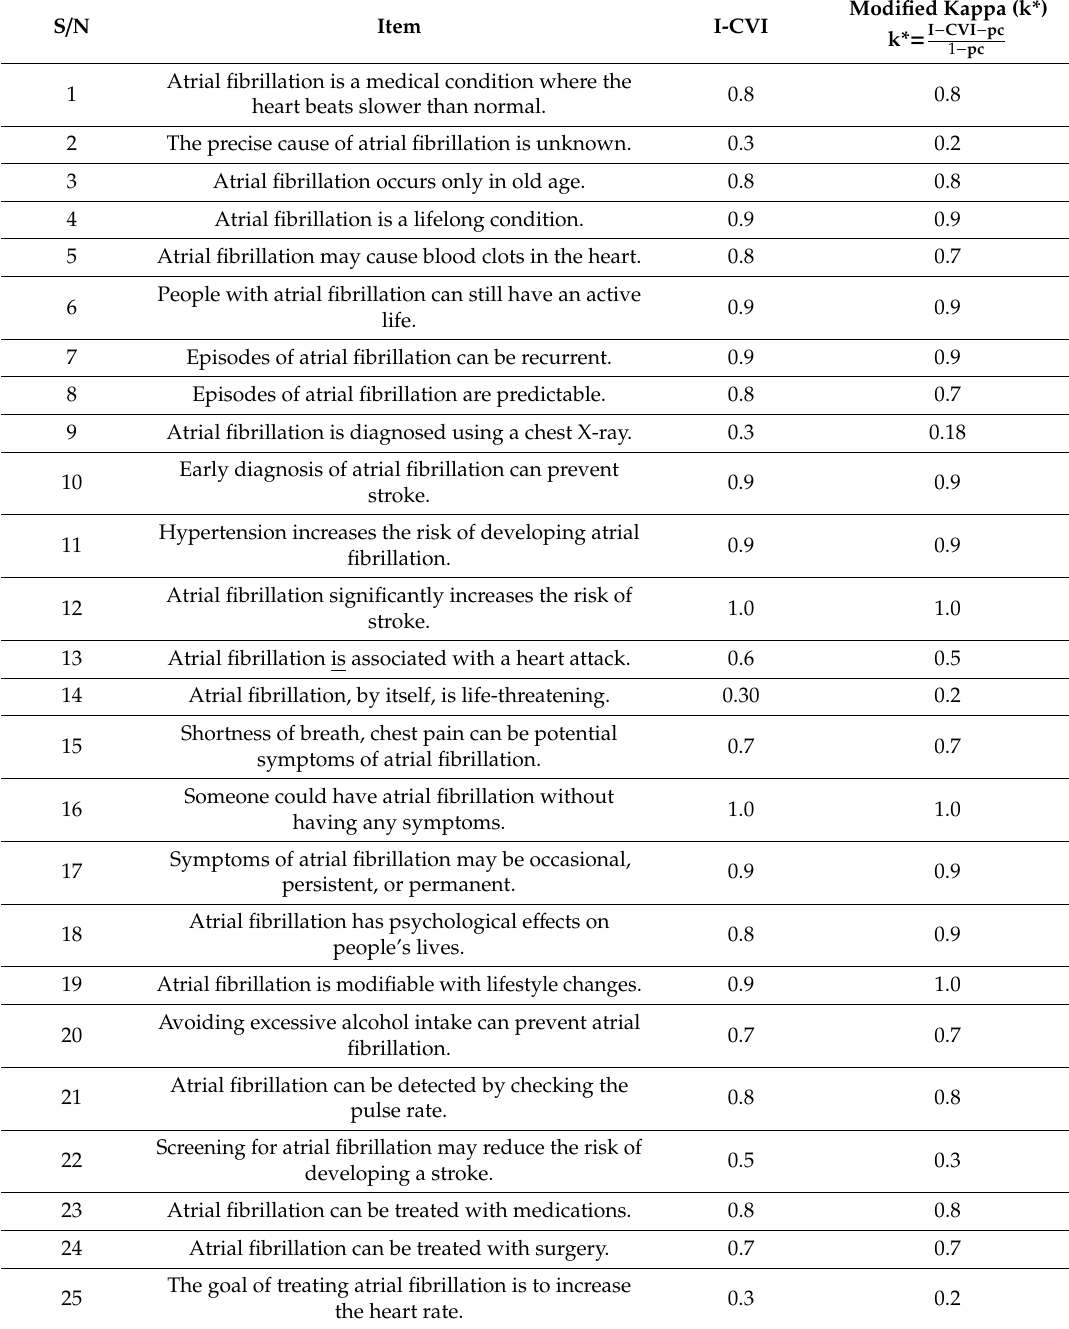
Table A1. Content validity and modified kappa of the individual items in the